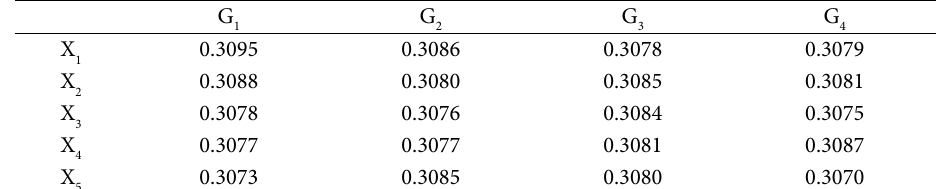
Table 8. Weight matrix (2) η